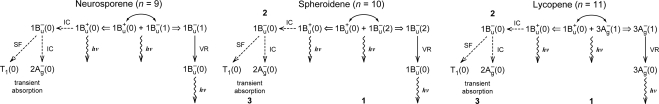
Relaxation schemes after coherent excitation to the 1Bu+(0) level of Cars (n = 9–11) bound to the LH2 complexes: The initial set of stimulated emission based on the quantum-beat mechanism is followed by transient absorptions: ‘VR’, ‘IC’ and ‘SF’ stand for vibrational relaxation, internal conversion and singlet fission. The numbering in the schemes corresponds to that of SADS shown in Figure 24; see also Figure 21 for comparison (Reproduced from Ref. [17]).